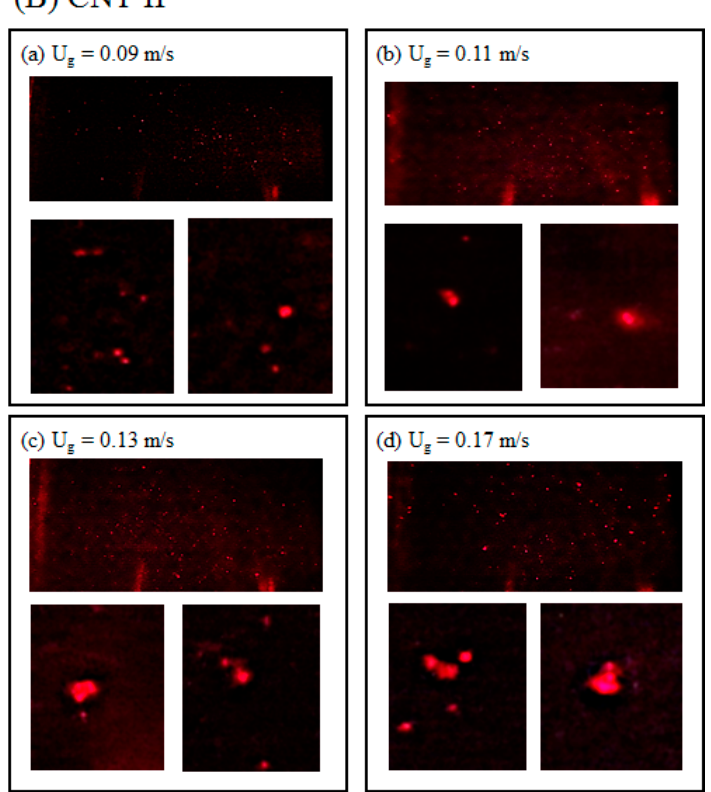
Figure 5. Original images (180 mm wide × 80 mm high) and representative aggregates at given gas velocities. ( A ) CNT I, ( B ) CNT II.